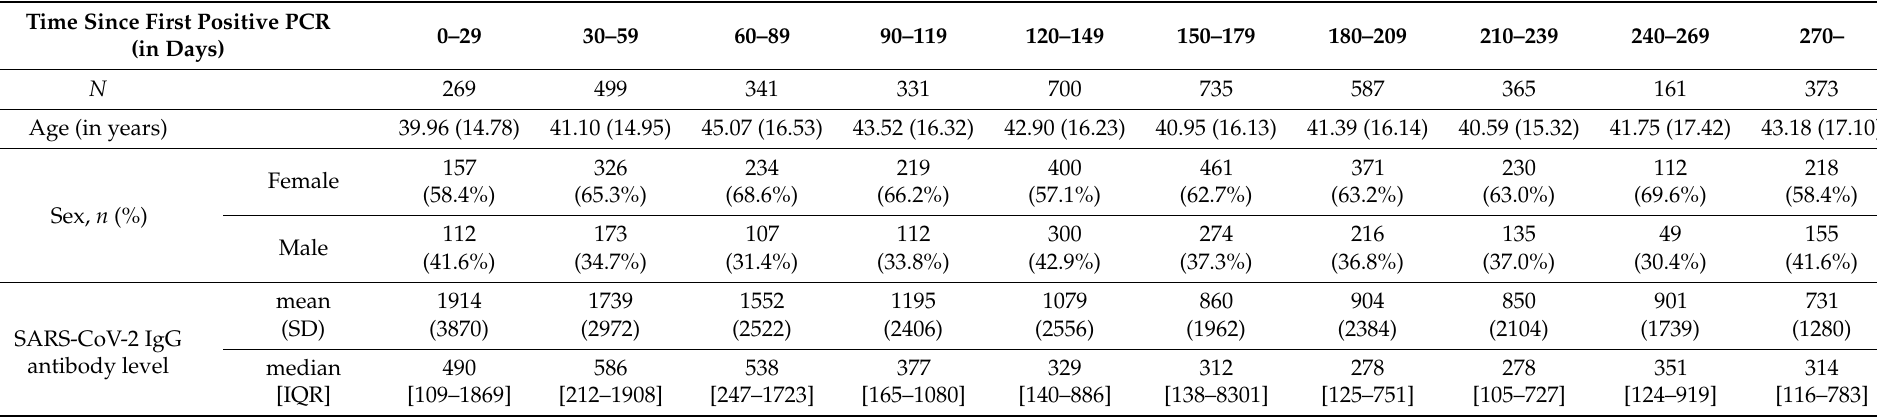
Table 3. Serology results of convalescent patients by 30 days intervals since second first positive PCR